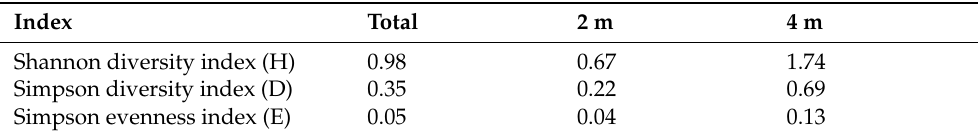
Table 6. Diversity and uniformity of the fouling community on larval collectors in Pisak Cove in